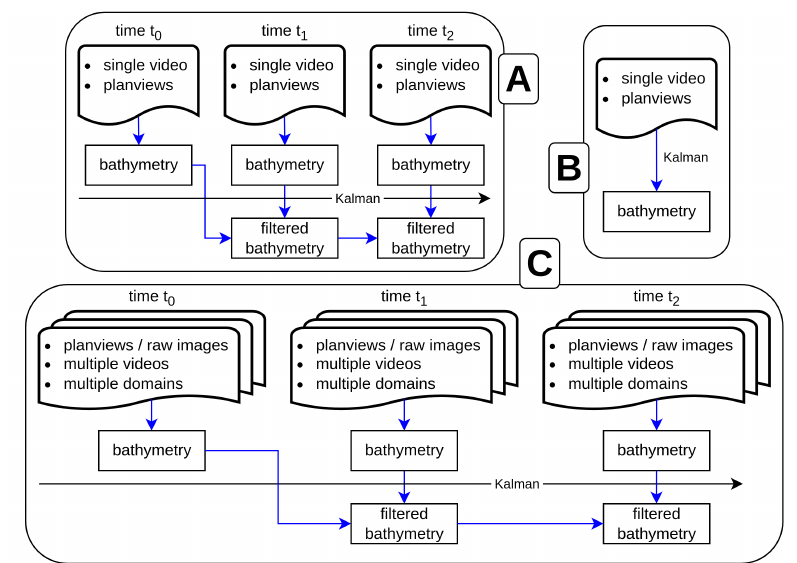
Figure 1. Basic characteristics in regard data input and use of Kalman filter for cBathy ( A ), COCOs ( B ) and the proposed improved version of UBathy ( C